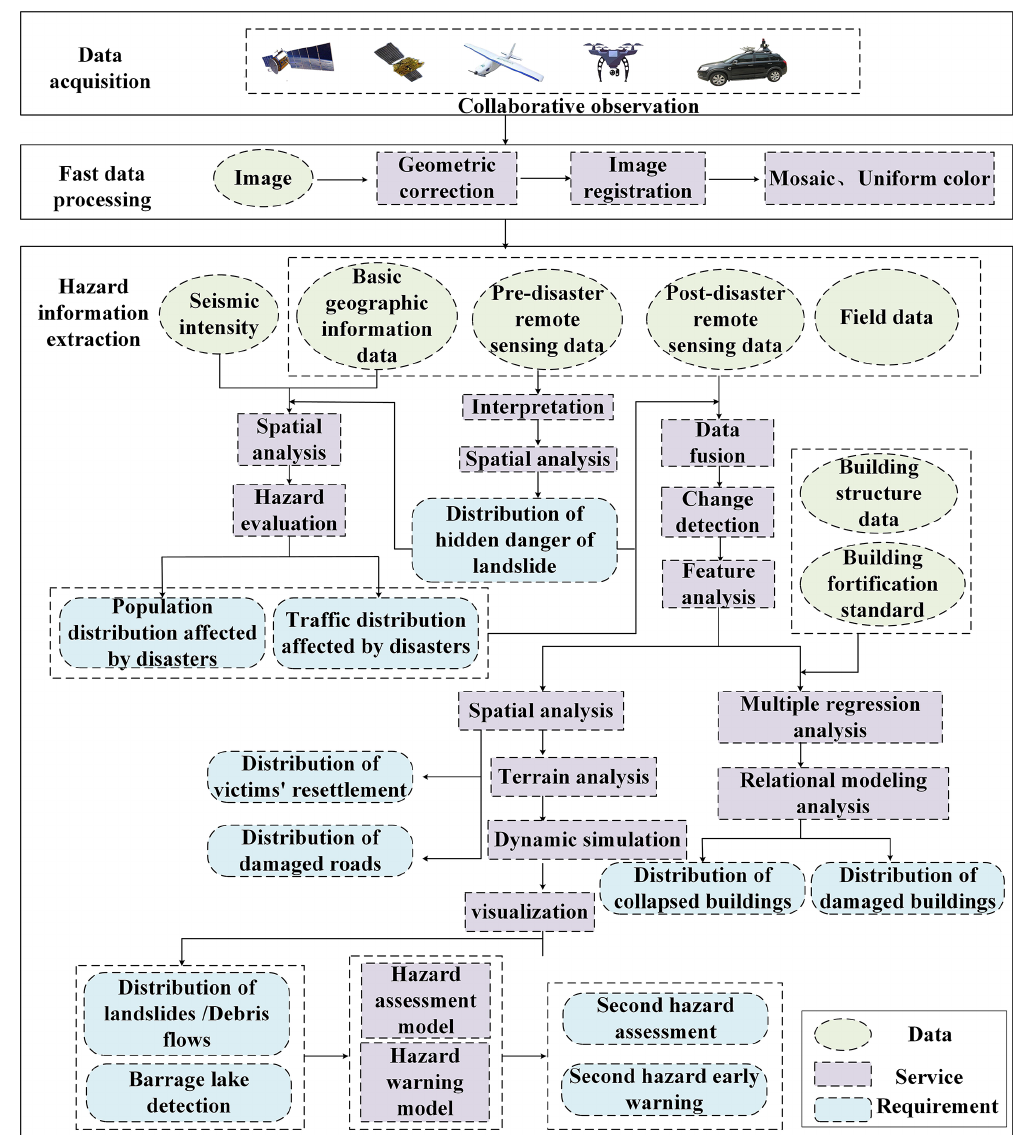
Figure 7. Earthquake remote sensing emergency response service